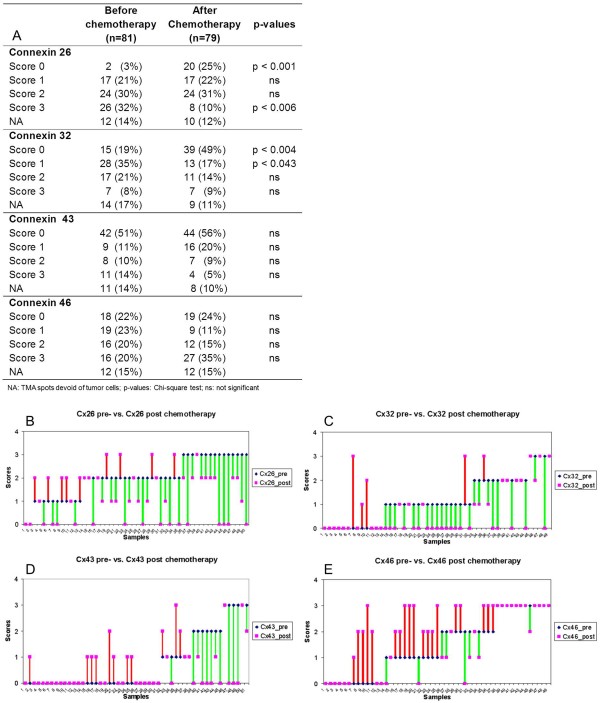
Expression of connexin isotypes in breast cancers before and after neoadjuvant chemotherapy (A). Dynamic changes in connexin isotype expression in the 50 (in Cx43, 51) matched breast cancer samples upon treatment (B-E). Cx26 (B) and Cx32 (C) levels mostly decreased, Cx43 (D) levels revealed the least change, while Cx46 (E) levels were mainly increased. Green lines represent decrease, red lines highlight increase. Violet symbols alone represent no change in expression.